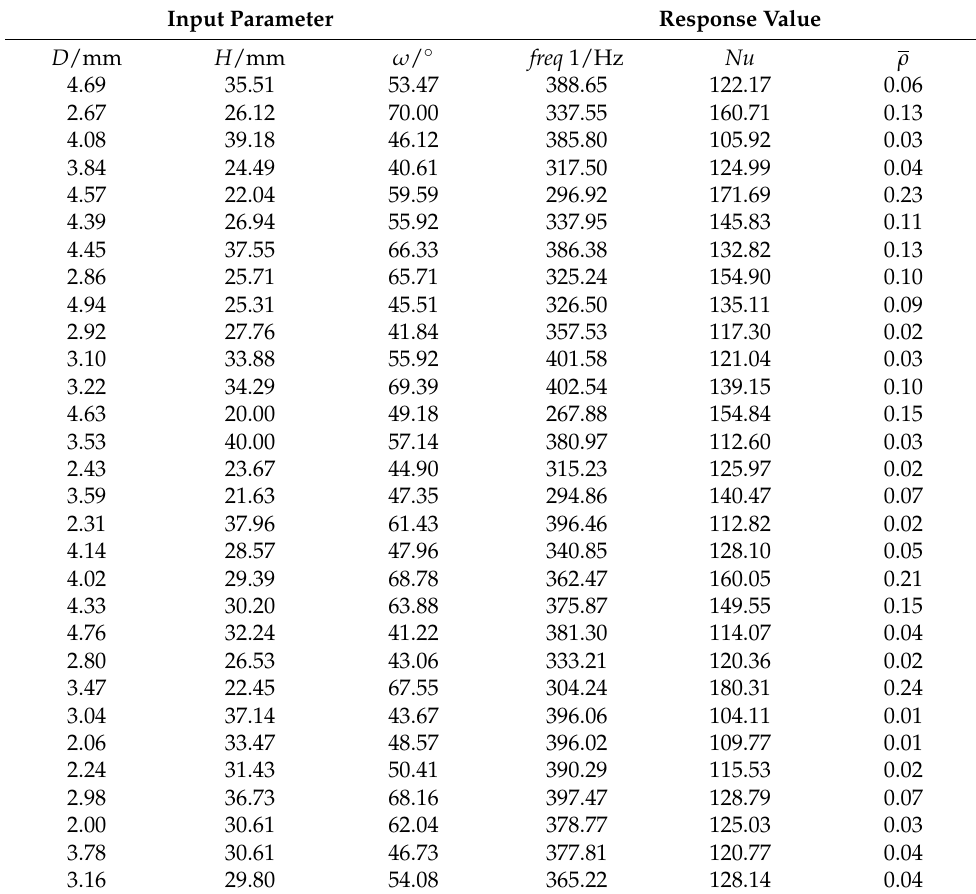
Table A1. Experimental design of the DOE optimal Latin